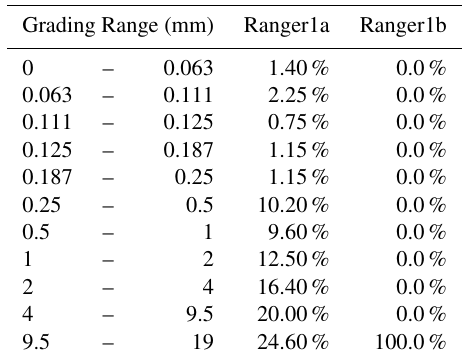
Table 3. Soil grading distribution data used for SSSPAM simula-